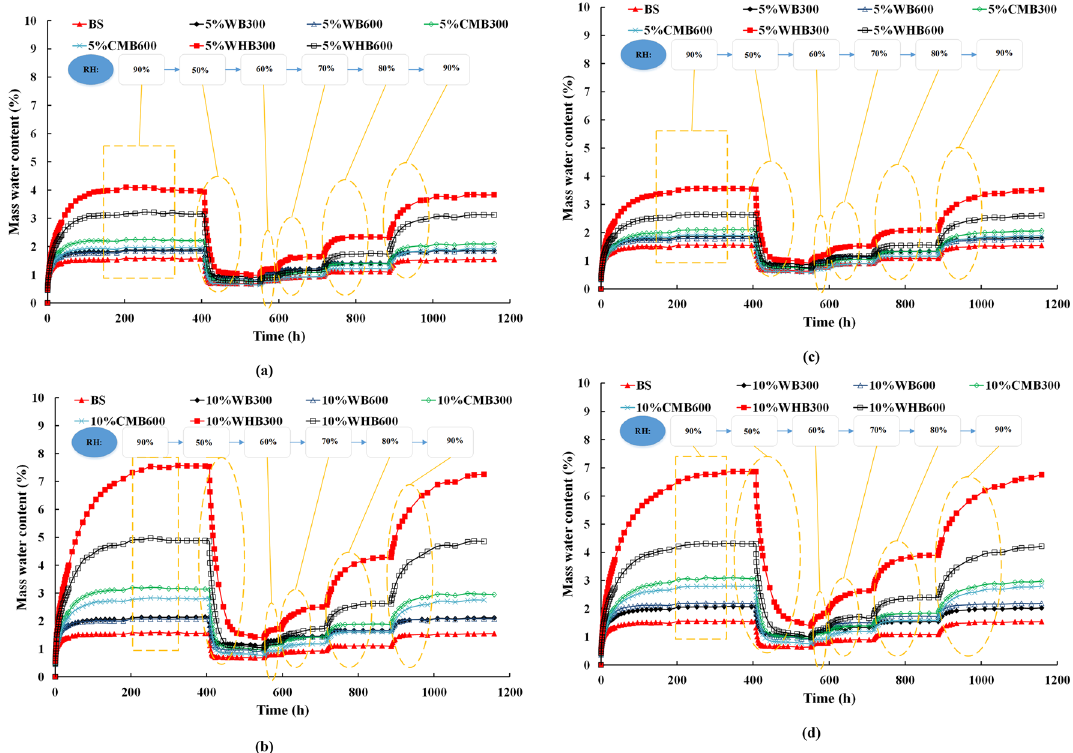
Figure 7. Water absorption behavior of different biochar amended ( a , b ) loose soil and ( c , d ) dense soil with time for various relative humidity conditions under 30 °C temperature